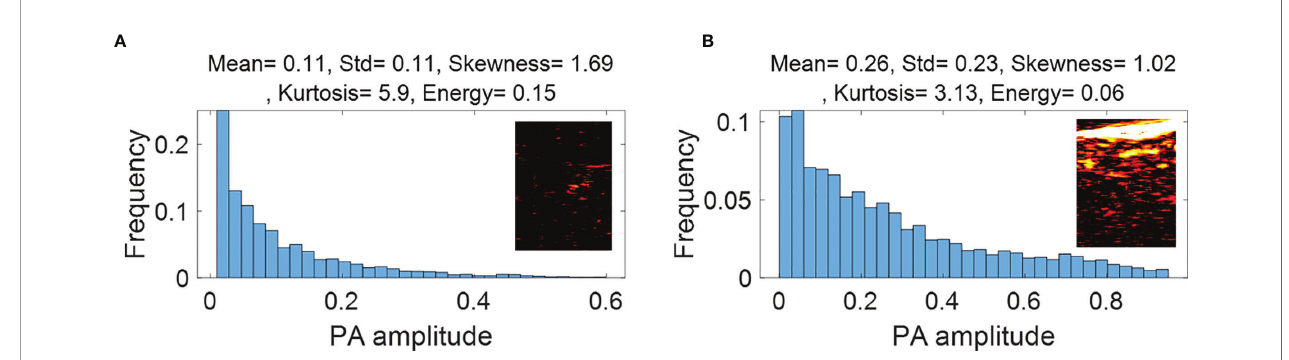
FIGURE 3 | First order statistical features calculated from malignant rectal tissue PAM ROIs (A) and normal rectal tissue PAM ROIs (B)